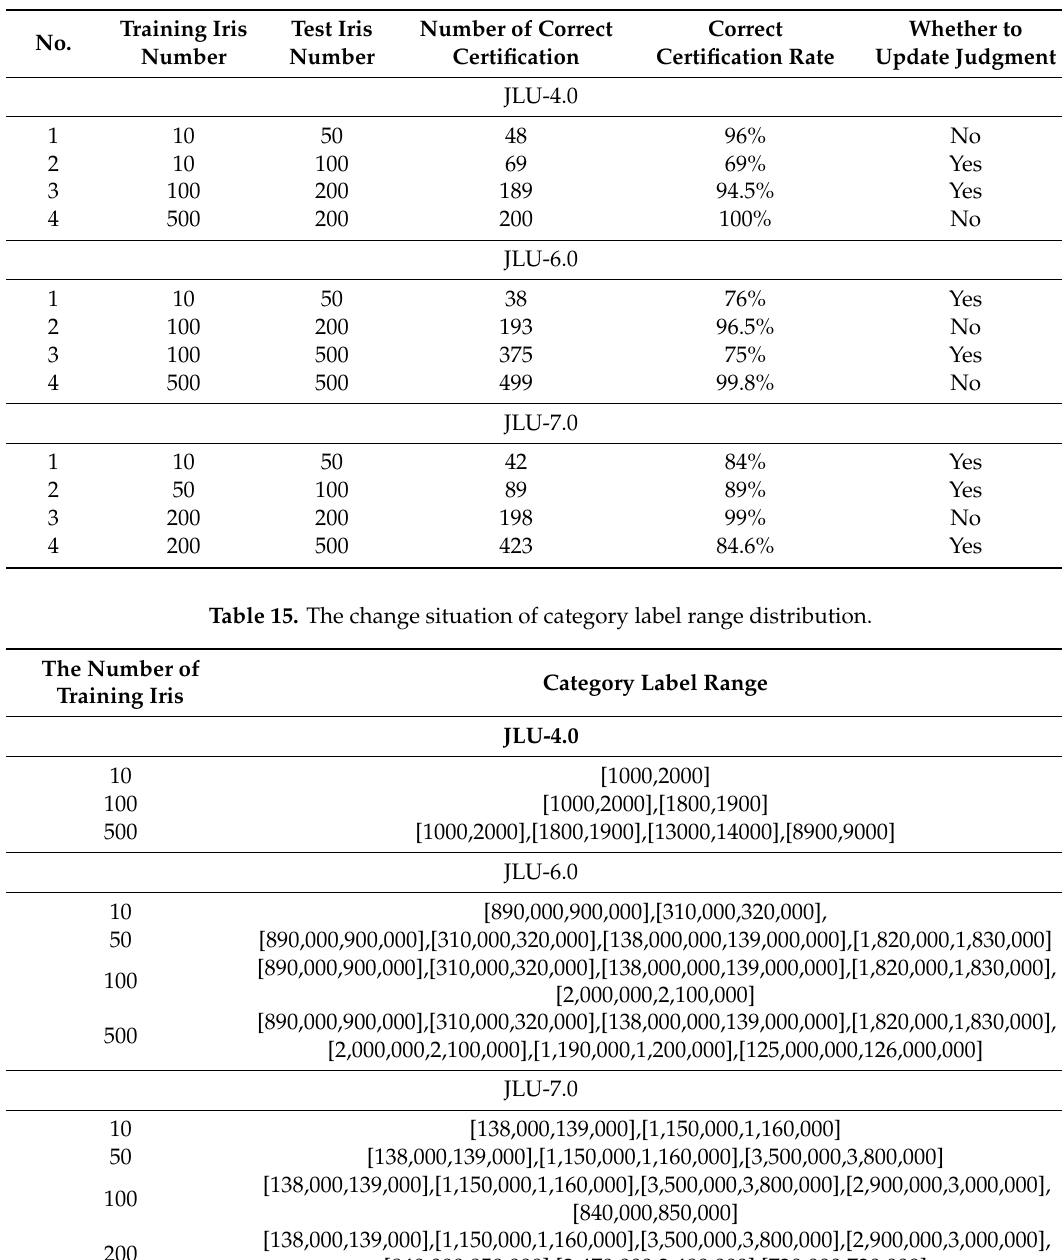
Table 14. Feedback and updates.